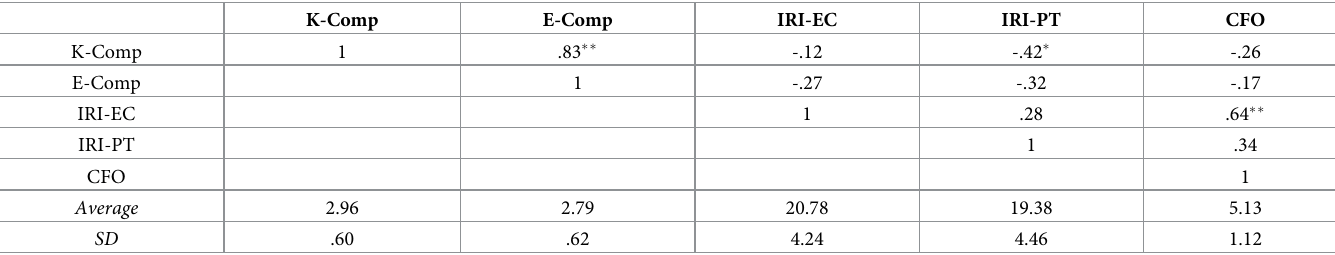
Table 2. Correlations between self-report measures and rated expression of